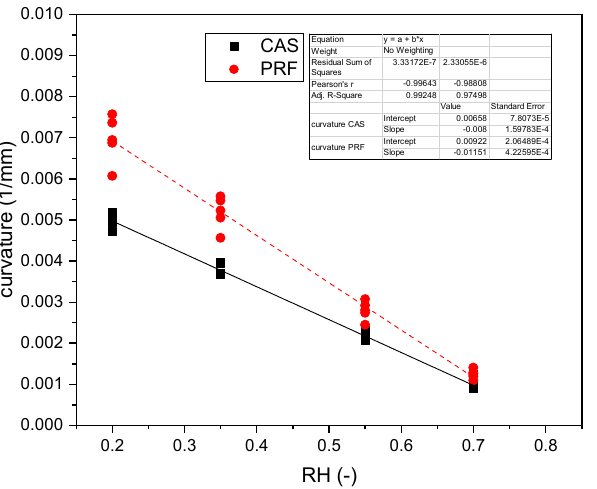
Figure 5. Experimental curvatures for bilayers made with casein adhesive (squares) and PRF adhe- sive (circles).